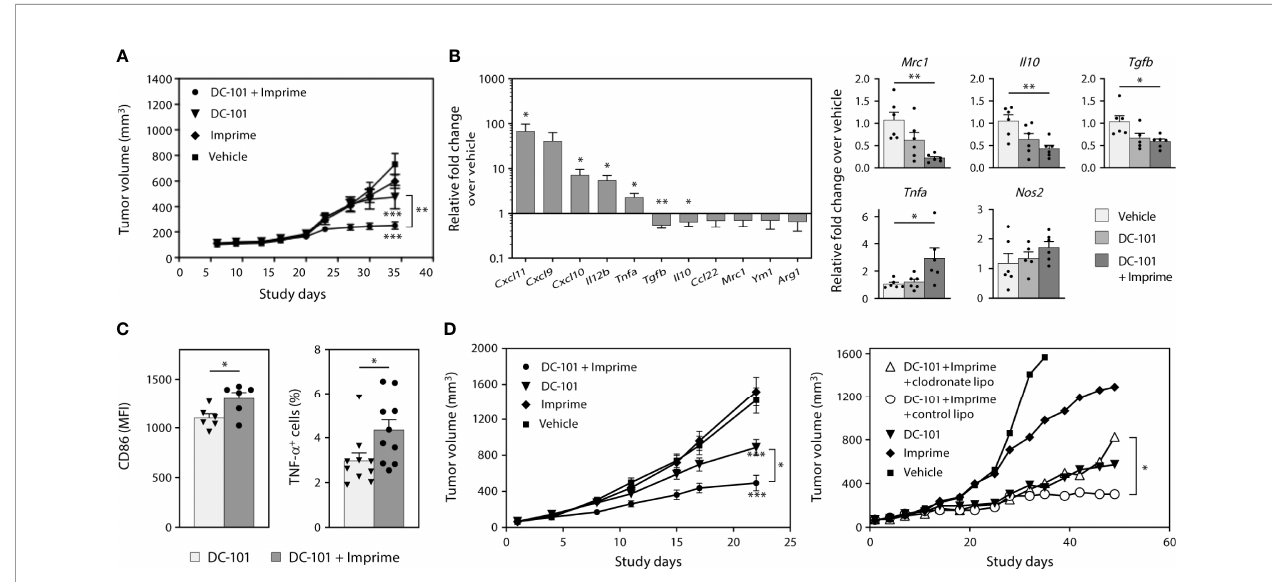
FIGURE 8 | Imprime remodulates tumor microenvironment and in fl uences anti-tumor ef fi cacy of anti-angiogenic agent in xenograft models. As described in Materials and Methods, H441 and H1299 non-small cell lung cancer xenograft tumor bearing nude mice were treated with anti-VEGF receptor 2 Ab DC-101 and/or Imprime (n = 10). (A) Tumor growth in the different treatment groups of the H441 model. (B) Changes in mRNA expression of M1/M2 markers of Imprime versus vehicle- treated tumor cell suspension, and changes in mRNA expression of M1/M2 markers of DC-101 versus DC-101+ Imprime and vehicle in tumor were evaluated. (C) Functional activities of TAMs were measured by CD86 expression and percent TNF- a + of LPS-stimulated TAMs using fl ow cytometry. (D) Tumor growth in the different treatment groups of the H1299 model and the effect of macrophage depletion on tumor growth using clodronate liposomes or control liposomes (n ≥ 7) were evaluated. Representative results from 2 experiments are shown. All summary data are presented as mean ± SEM. Two-way ANOVA analysis and Tukey multiple comparison were used in (A, D) , Unpaired Student ’ s t test was used in (B-left, C) and One-way ANOVA with Dunnett multi-comparation was used in (B-right) . * p < 0.05, ** p < 0.01, *** p <